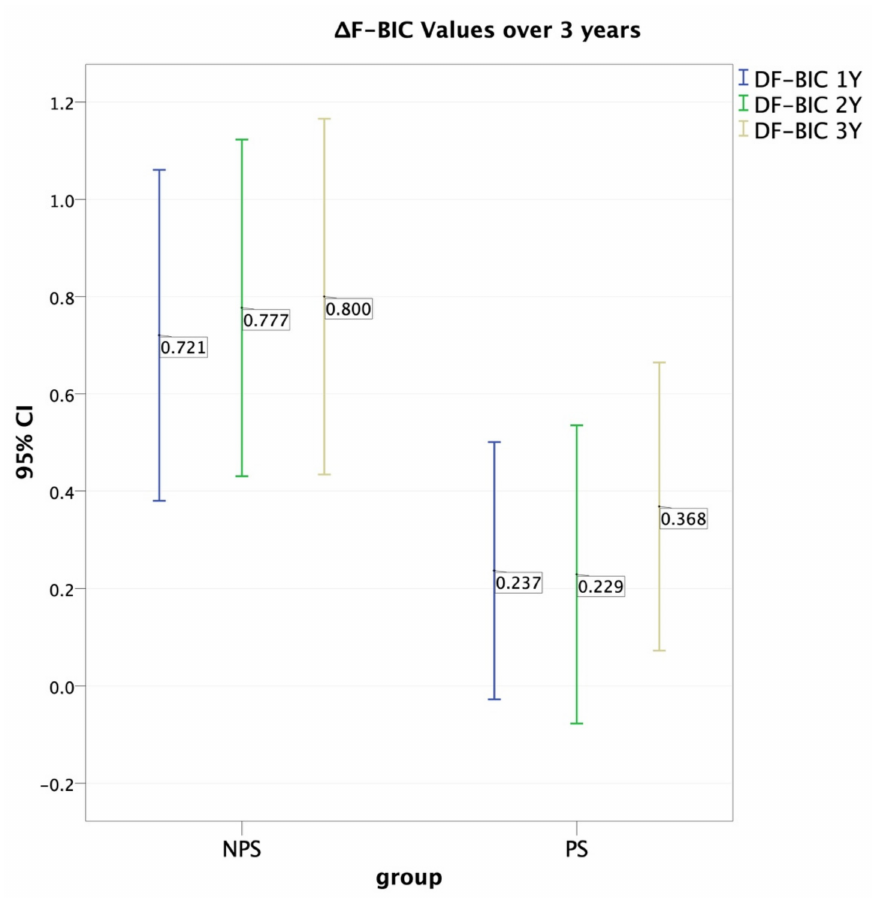
Figure 7. ∆ FBIC values during follow-up period. Amount of bone loss (mm) was higher for NPS implants compared to PS implants during observation